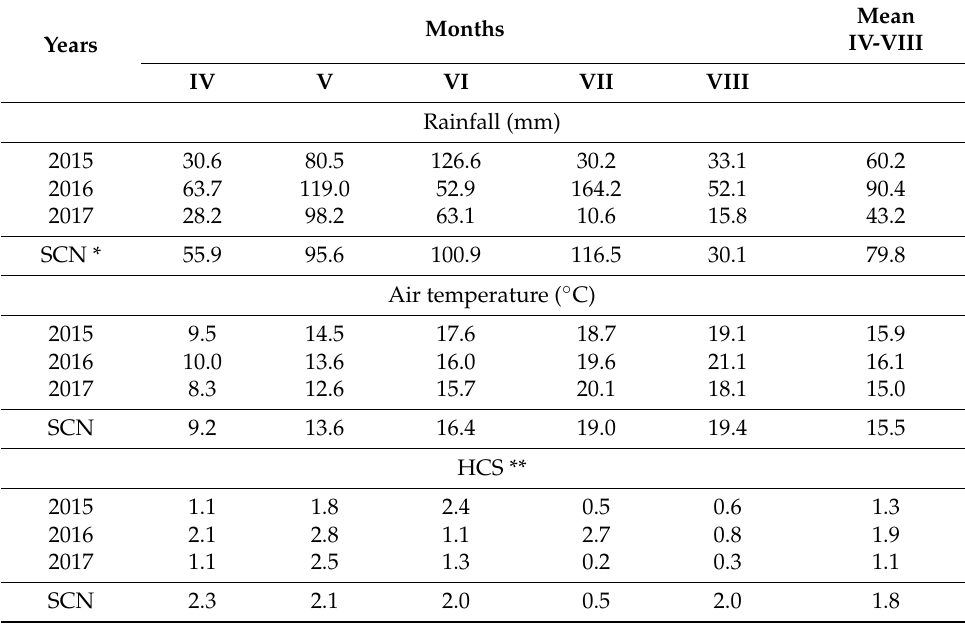
Table 1. Meteorological conditions during bean growth in 2015–2017 according to the meteorological station in